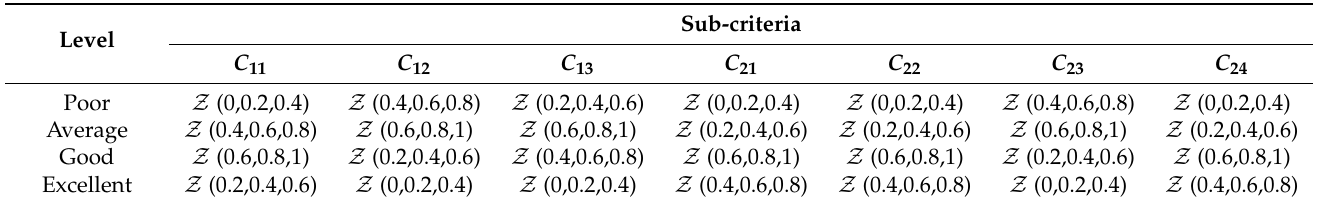
Table 10. The score matrix.